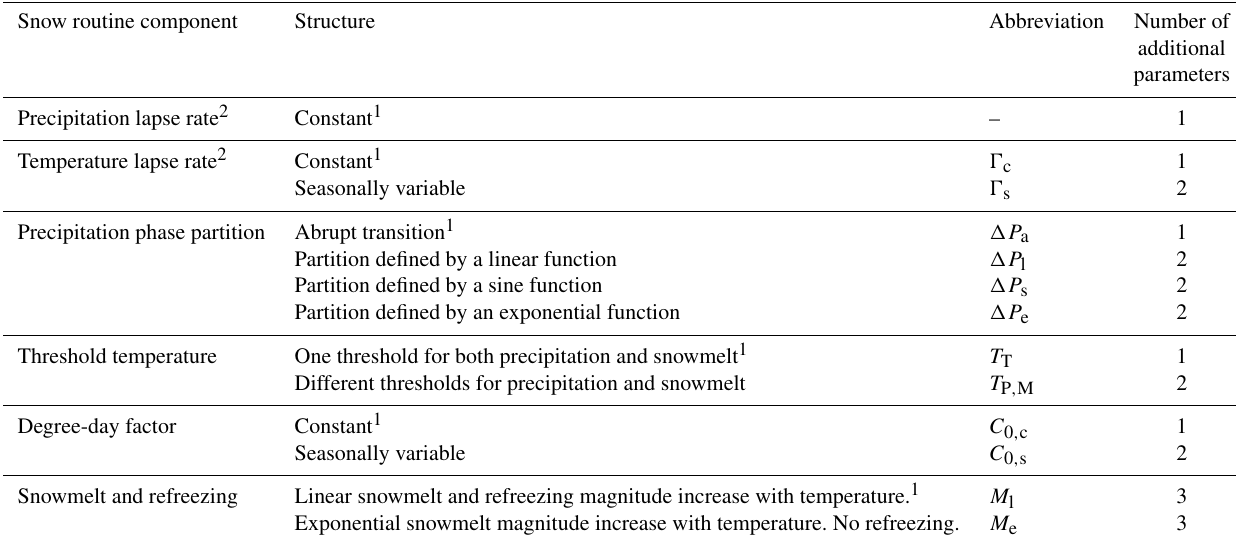
Table 1. Description of the proposed modifications to the snow routine of the HBV model. The default component structures of the HBV model are marked with a 1 symbol. The components marked with a 2 are not part of the snow routine but were included in the analysis due to their significant impact on